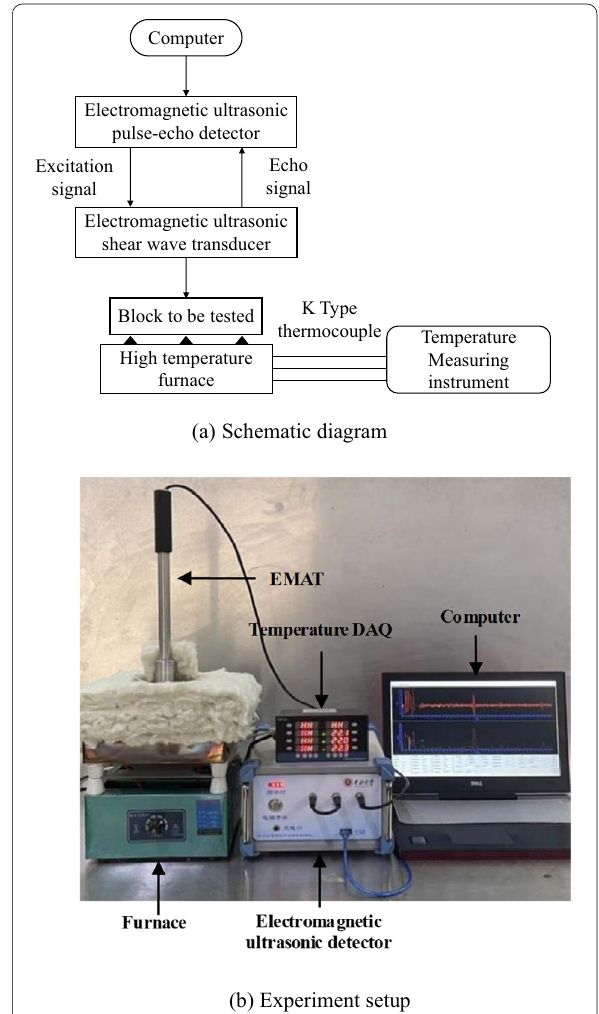
Figure 6 High-temperature experimental